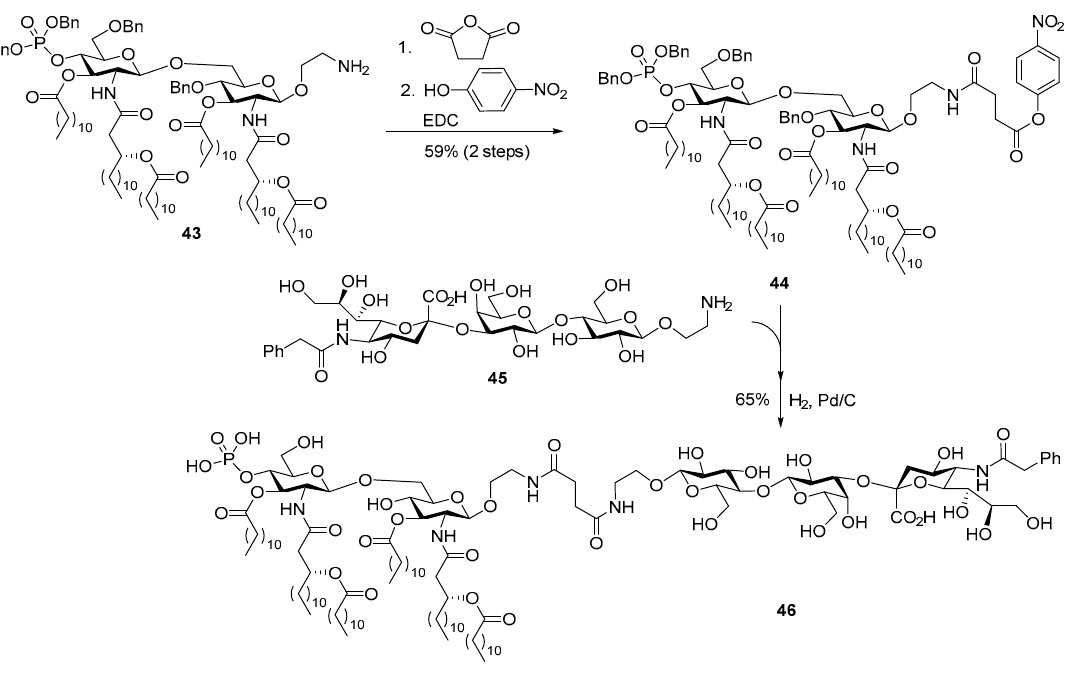
Scheme 9. Conjugation of N. meningitidis MPLA with a modified GM3 antigen to form conjugate vaccine 46